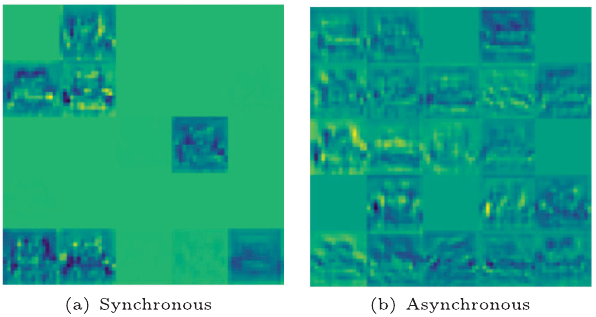
Fig. 1 Features learned by sync and async